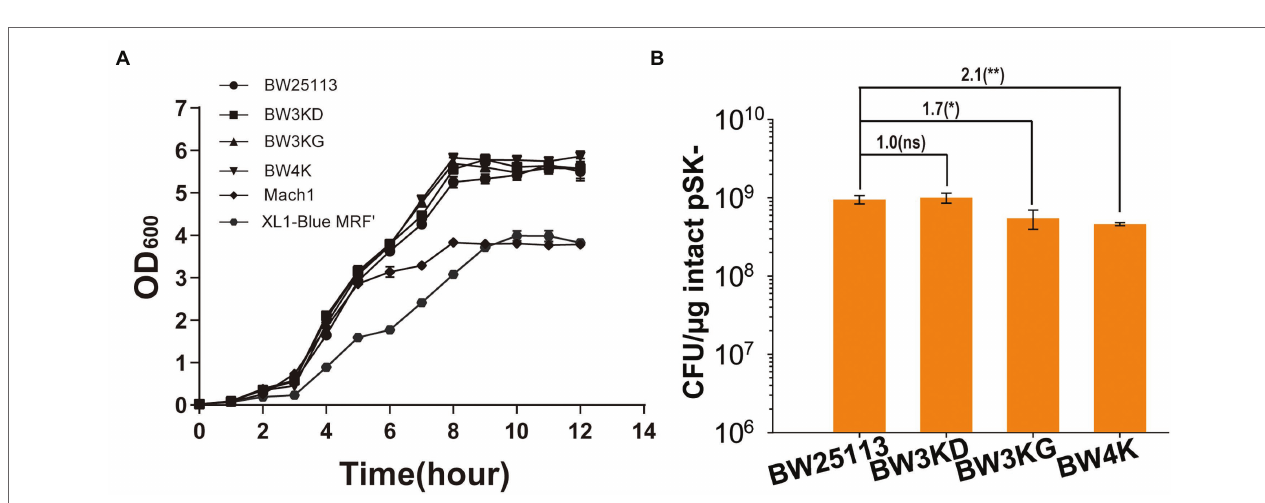
FIGURE 4 | The effect of gene deletion of the growth and TE of E. coli BW25113. (A) The growth curves of BW25113, BW3KD, BW3KG, and BW4K. The latter two are commercially available cloning strains. (B) TEs of these strains. Unpaired t-tests were performed (*** = p < 0.001). The numbers before (***) represent the difference by folds. The “ns” shown in the figure means the p value is higher than 0.05. The numbers before (**) represent the difference by folds. Data are averages of three samples with standard deviations (error